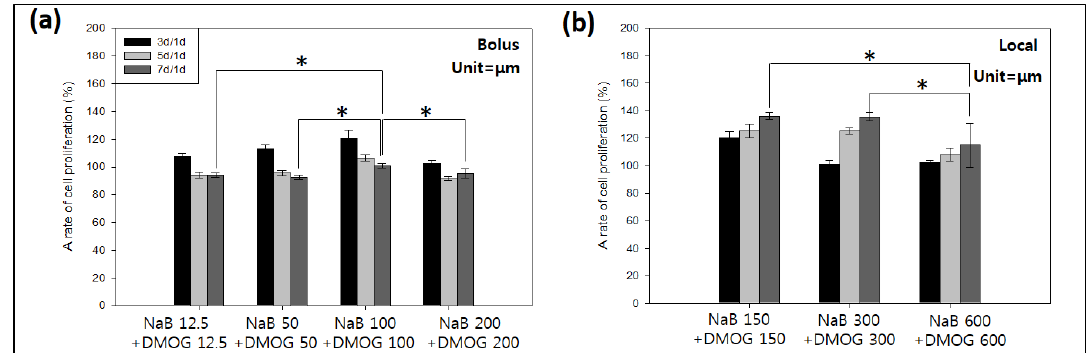
Figure 10. Cell proliferation results of MC3T3 cells in ( a ) bolus, and ( b ) local delivery with 12.5, 50, 100, 150, 200, 300 and 600 µM of DMOG and NaB, measured by CCK-8 assay.